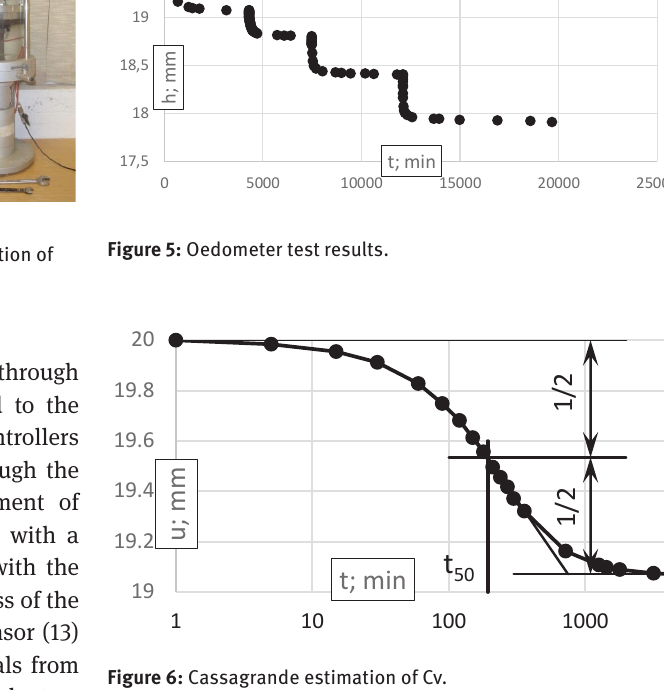
Figure 5. Oedometer test results